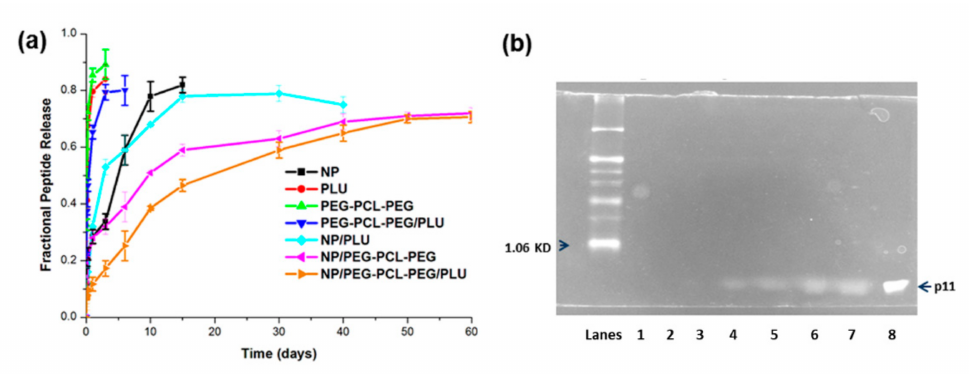
Figure 6. Graphical depiction of swelling ratio of the investigated hydrogel